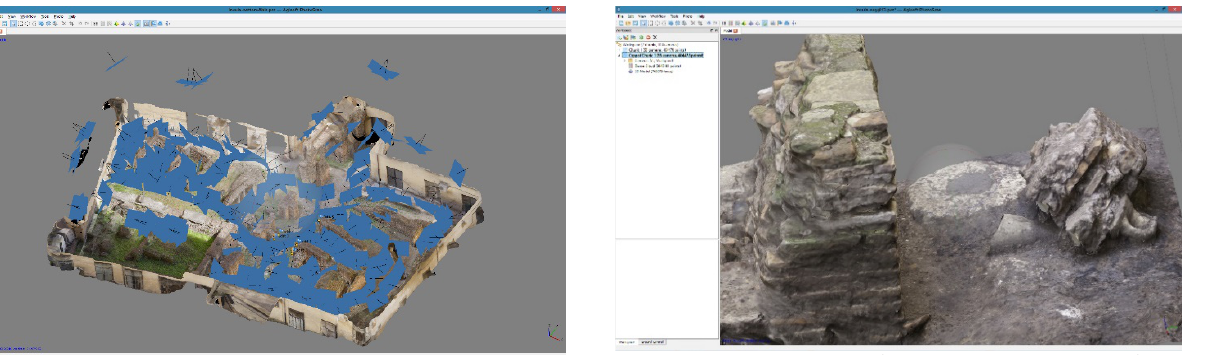
Fig. 16 Derived camera poses (257 images) in Photoscan and 3D model for the Insula Volusiana.